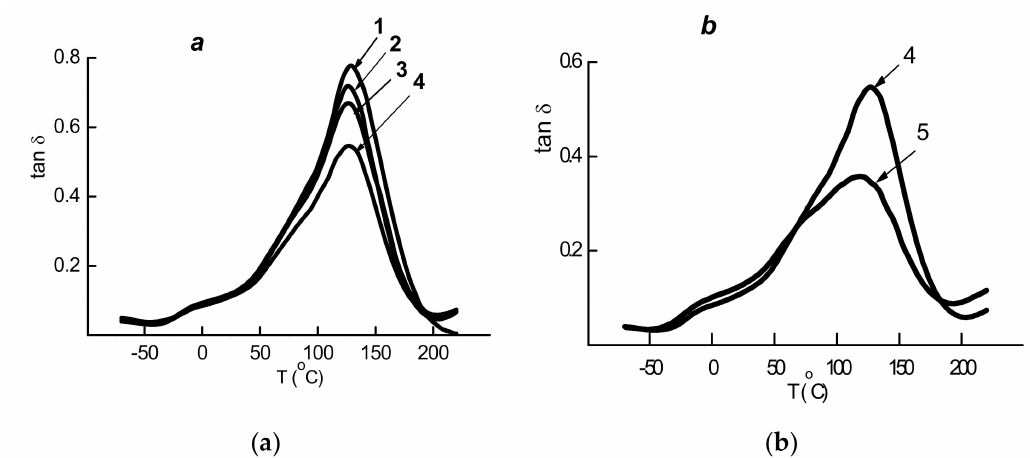
Figure 4. Temperature dependencies of tan δ ( a , b ) for the samples of the IPNs (1), OI IPNs-1 (2), OI IPNs-2 (3), OI IPNs-3 (4), OI IPNs-4 (5). The composition of the samples is given in Table